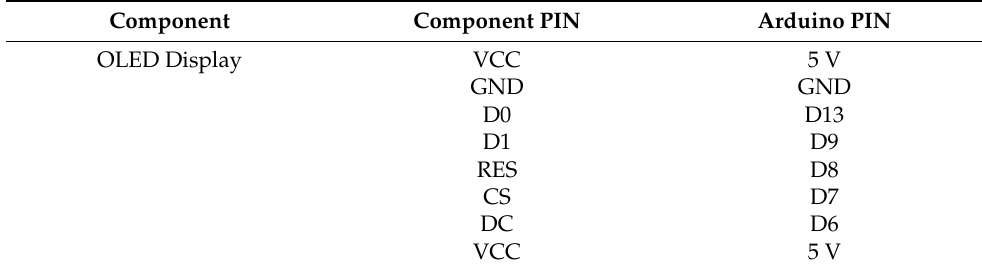
Table 3. The Tech-Glove PIN Schema for the